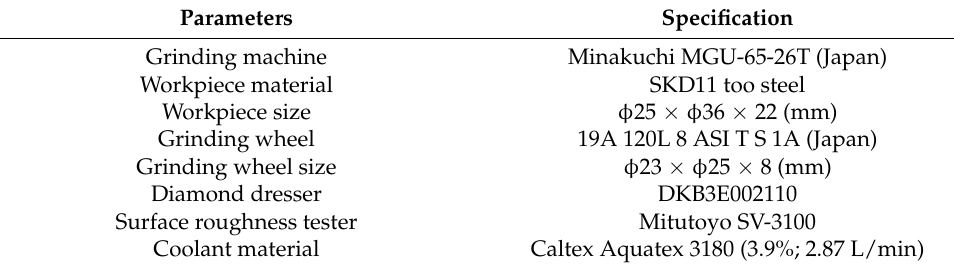
Table 3. Specifications of the experimental setup.